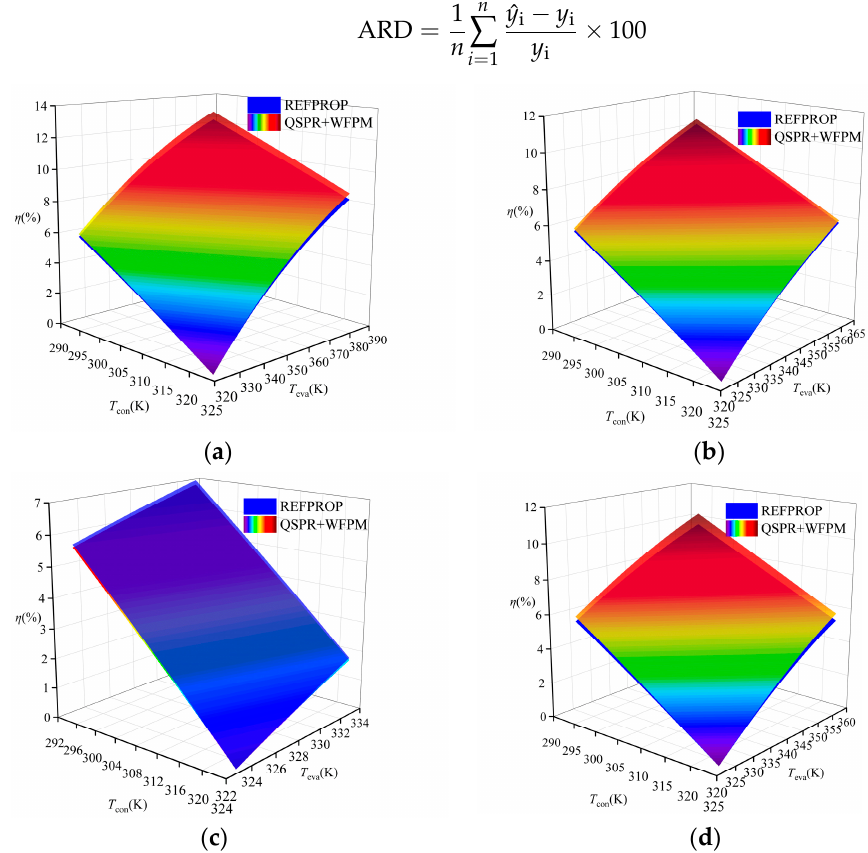
Figure 9. Comparison of thermal efficiency at different temperatures: ( a ) R245fa; ( b ) R600a; ( c ) R134a; ( d ) R1234ze(E).